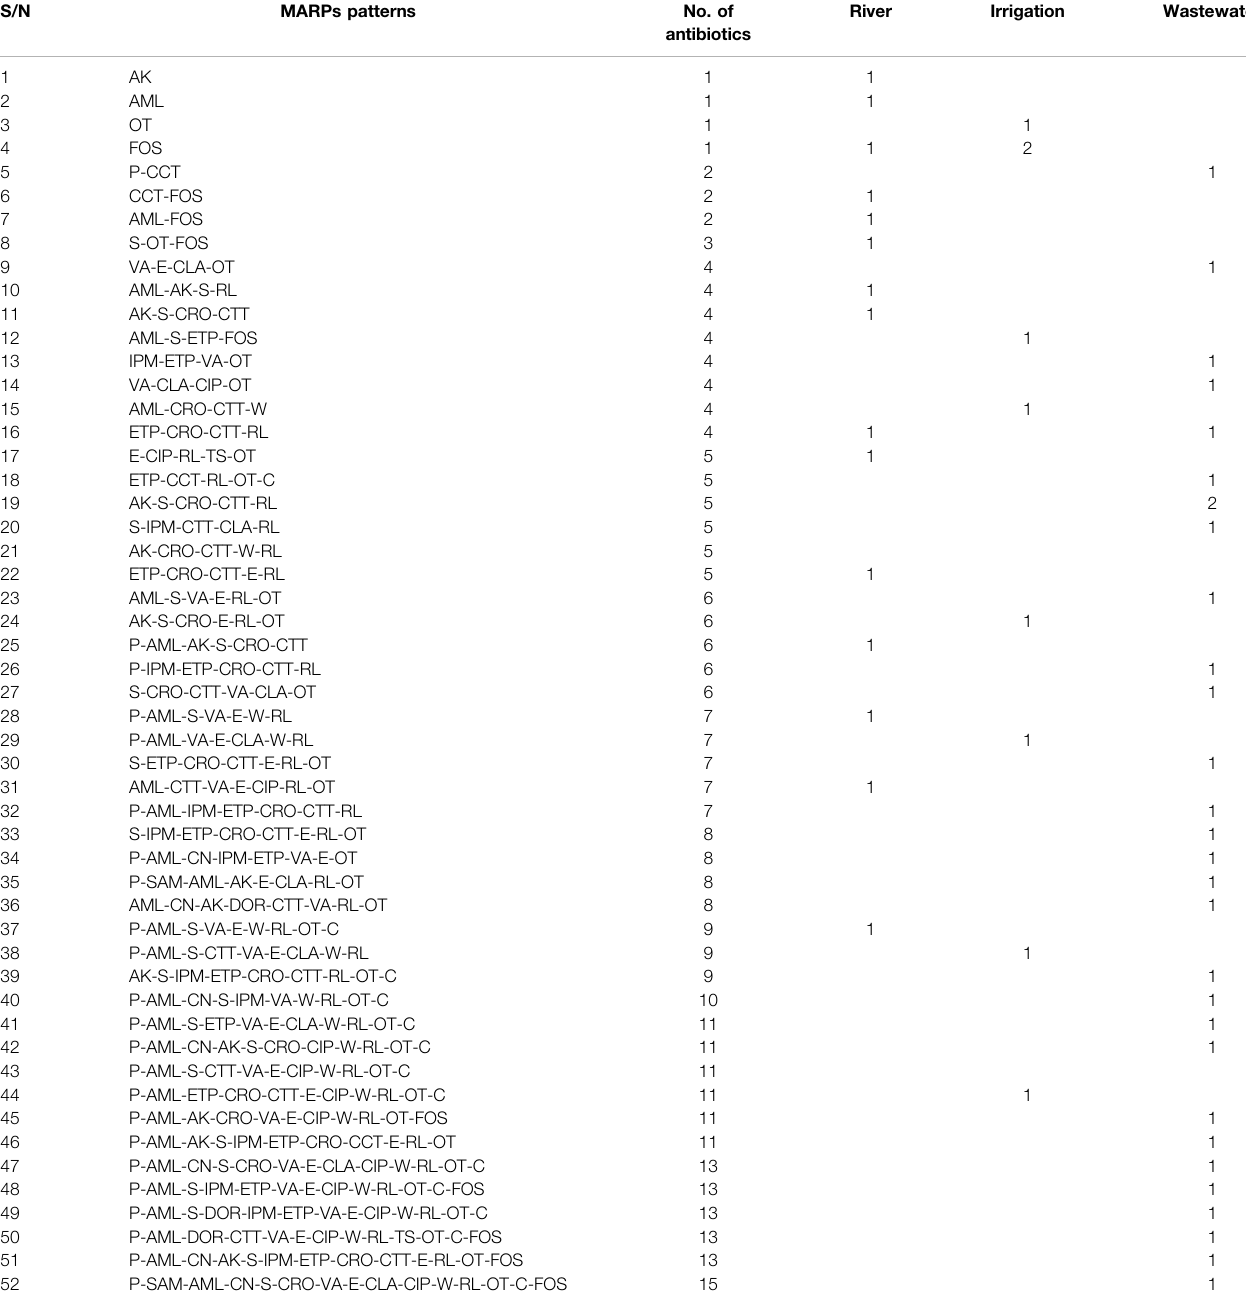
TABLE 3 | Distribution of Multiple/Antibiotic Resistance Phenotypes ((M)ARPs) of Listeria monocytogenes isolates from environmental waters.